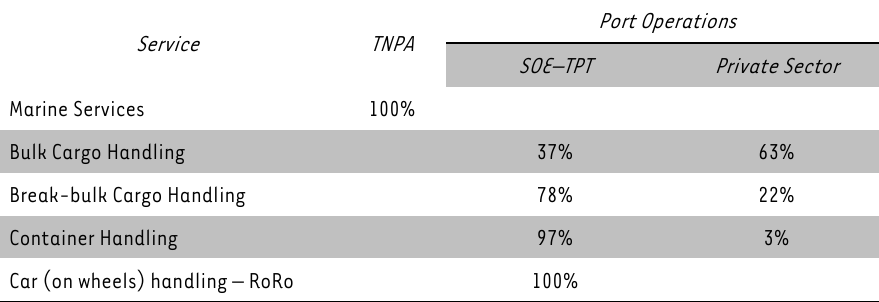
TABLE 1: Public-Private Interface in Terminal